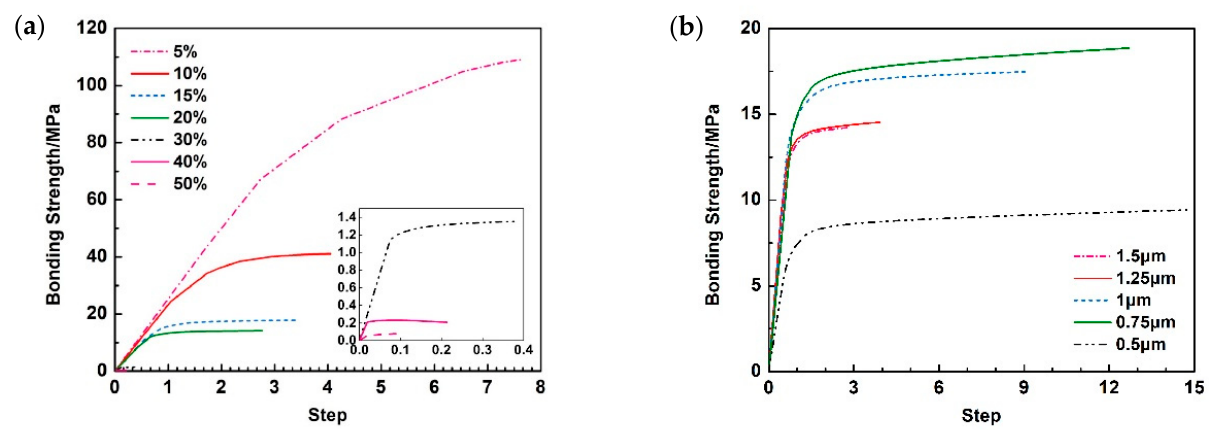
Figure 10. Curves of tensile strength versus loading steps: ( a ) 1.5 μ m pore diameter, ( b ) 20% porosity.